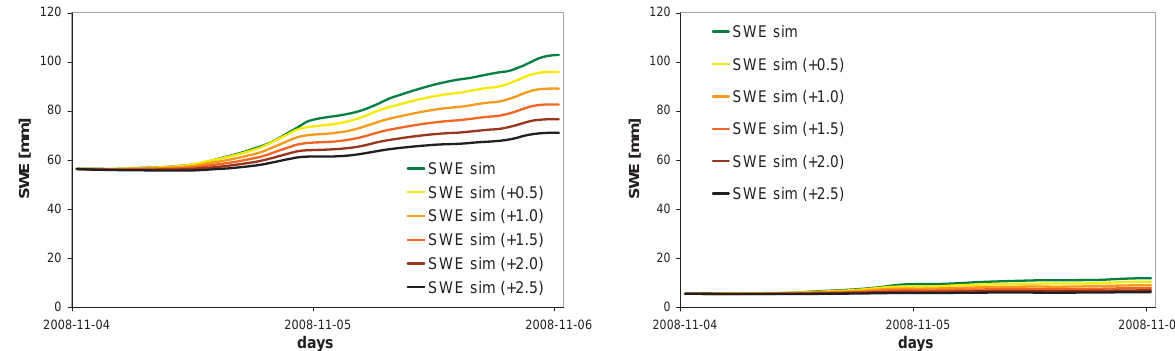
Fig. 12. SWE simulations over the Toce (left) and Sesia (right) basins. The snow water equivalents simulated by the FEST-WB forced with all observed data are shown by the green lines, while coloured dashed lines refer to discharge simulations by the FEST-WB model forced with modified temperature fields at 0.5 ◦ C intervals. Data are shown in mm on the y-axis; the scale plot is the same for the two basins to highlight the SWE differences. The figure shows a zoom on 4 and 5 November when heavy rainfall over the north-western part of the Piedmont region